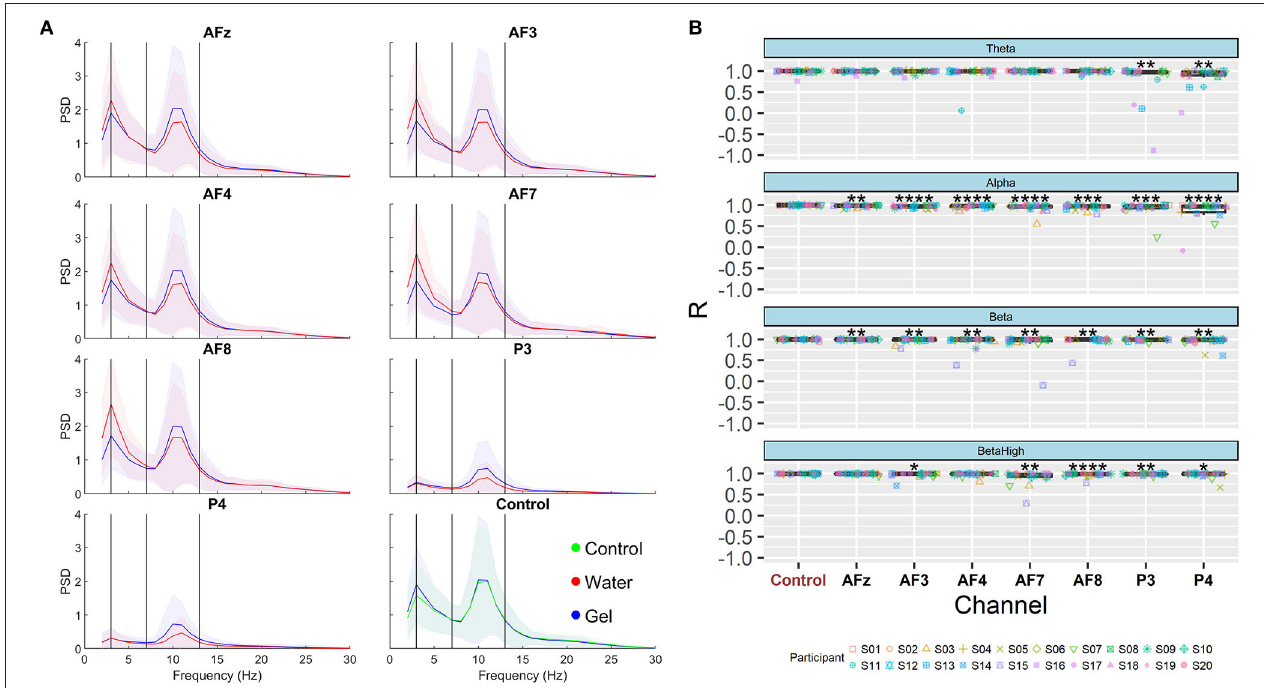
FIGURE 5 | Spectral analysis. (A) EEG spectra for each channel in the interval 2–30Hz. Spectra obtained with water electrodes are shown in red, and spectra obtained with gel electrodes are shown in blue. The last subplot shows the AFz-gel and control electrode. The solid lines represent the average of the spectra over the population, and the shadowed areas represent the standard deviation. (B) Boxplots of Pearson’s correlation values computed between water and gel electrodes for each channel and band. Each distribution has been compared with the values obtained from AFz-control correlation. The asterisks show the results of the Wilcoxon